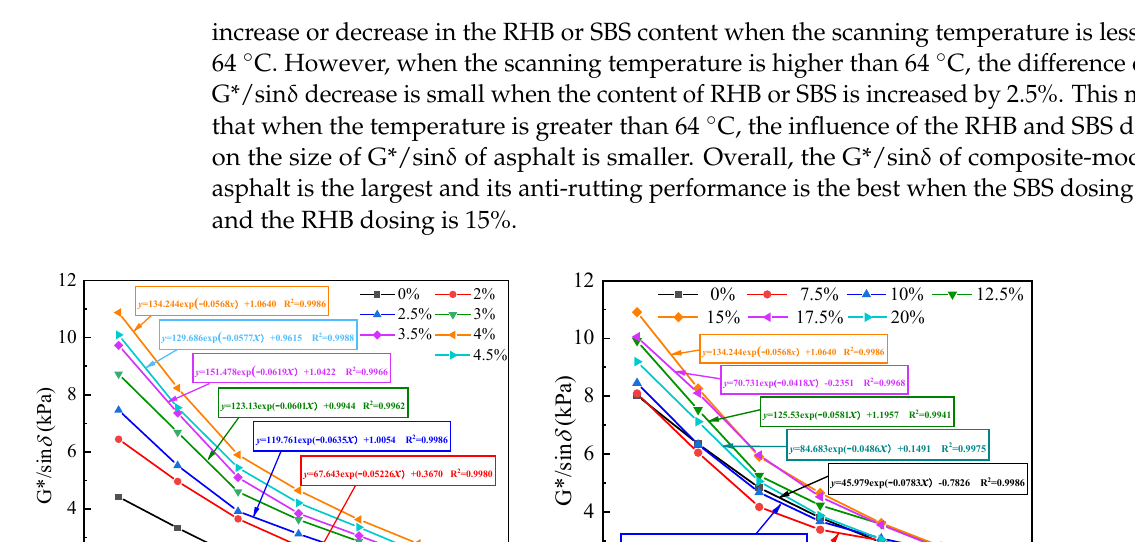
Figure 9. ( a ) Rutting factor of different content of SBS, ( b ) rutting factor of different content of RHB. The G*/sin δ curves under different temperatures and variable conditions were fitted, and the fitted curve formulas were all exponential functions in the form of y = A 0 e R 0x + A 1 , in which the exponential coefficient R 0 had a great influence on G*/sin δ . The exponential coefficient R 0 ranged from − 0.0783 to − 0.0418. The larger the value of R 0 , the faster the G*/sin δ curve decreases, and the greater the influence of temperature. In this paper, the optimal fitting curve of the G*/sin δ curve under different content of SBS and RHB is: G*/sin δ = 134.244e − 0.0577x + 1.0640